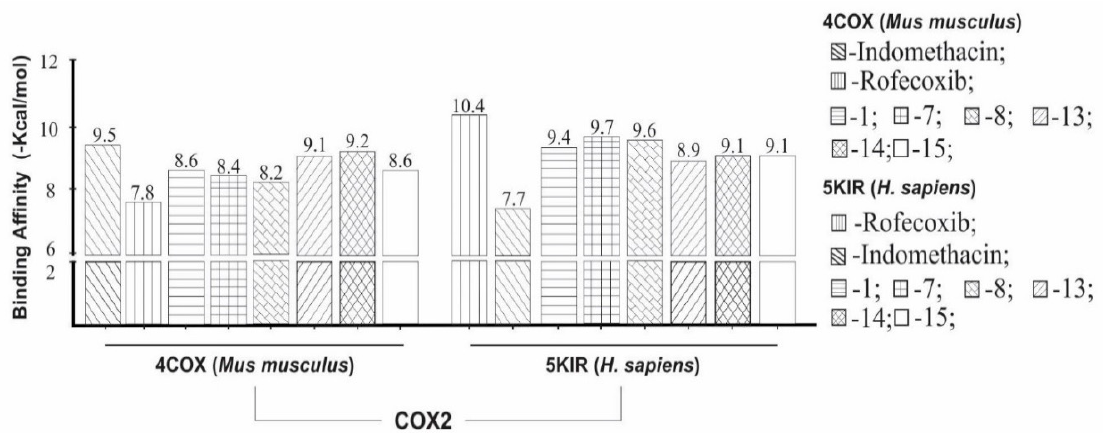
Figure 7. Binding affinity provided by AutoDock/Vina software of the phenylbutazone derivatives (structures 1 , 7 – 15 ) and standard ligands. Ligand control for COX-2 organism Mus musculus and Homo sapiens were indomethacin and rofecoxib.